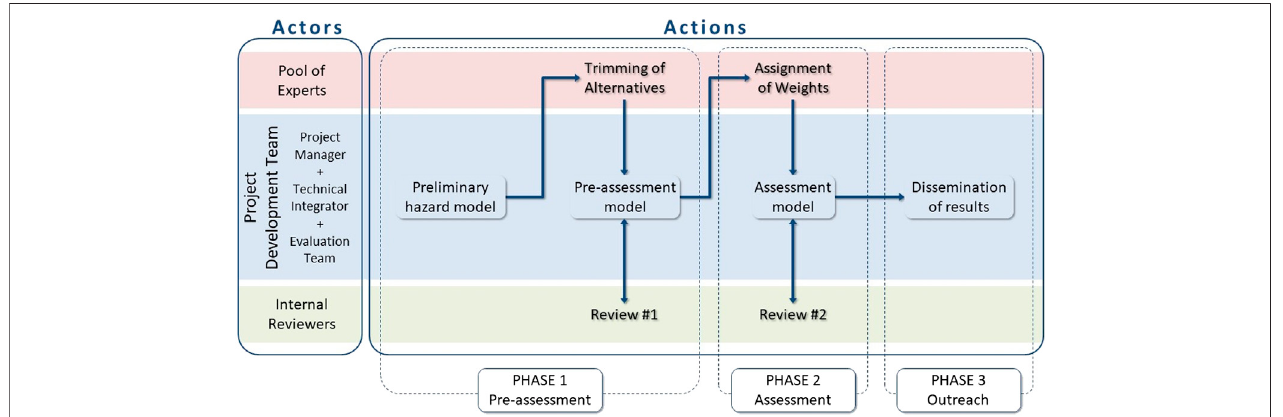
FIGURE 2 | Schematic illustration of the project ’ s actors and correlative actions subdivided into three PHASES (Supplementary Data Sheet S1.1) . Notice that both phase1andphase2includeanelicitationexperimentandarevisionstageeach.PHASE3includestheNEAMTHM18 Documentation(Basilietal.,2019)ofthetwo preceding PHASES, a web mapper to access the main results of the hazard assessment, scienti fi c publications, and some materials for illustrating the results to the general public (e.g., Layman ’ s Report).